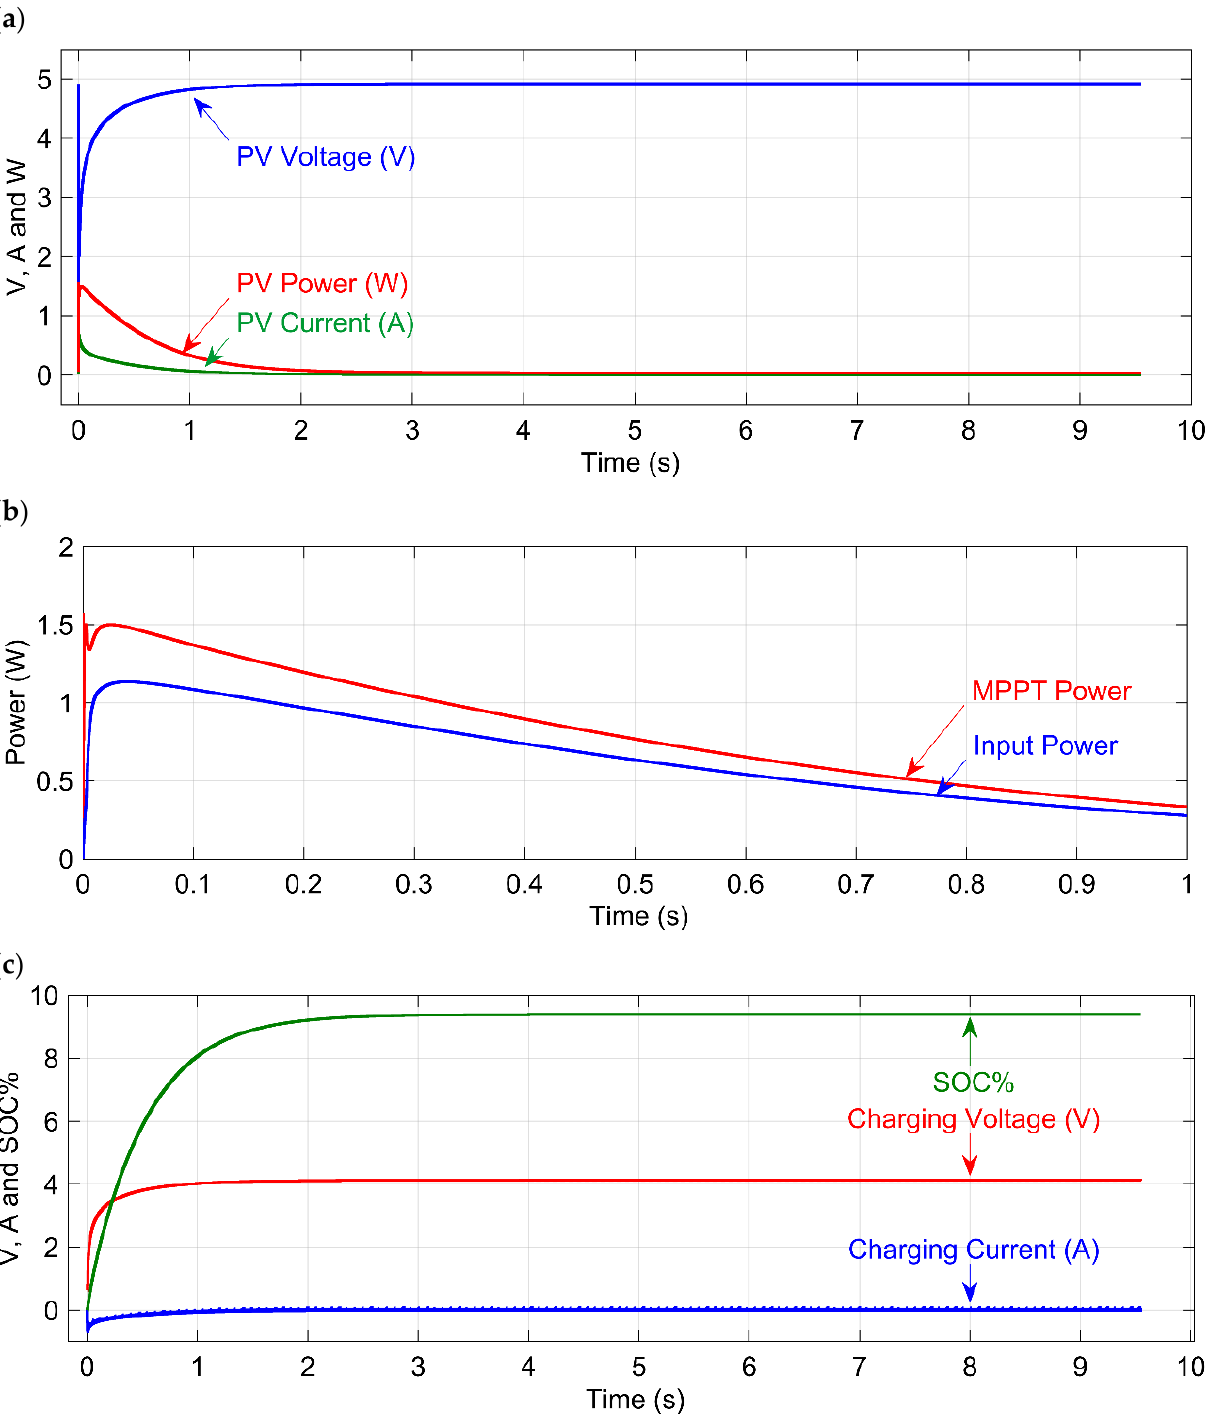
Figure 6. Simulation results; ( a ) generated voltage (V), current (A), and power (W) from the solar PV module; ( b ) generated power (W) without MPPT tracker and power with MPPT tracker (W); ( c ) charging voltage (V), charging current (A), and SOC (%) of the SC.